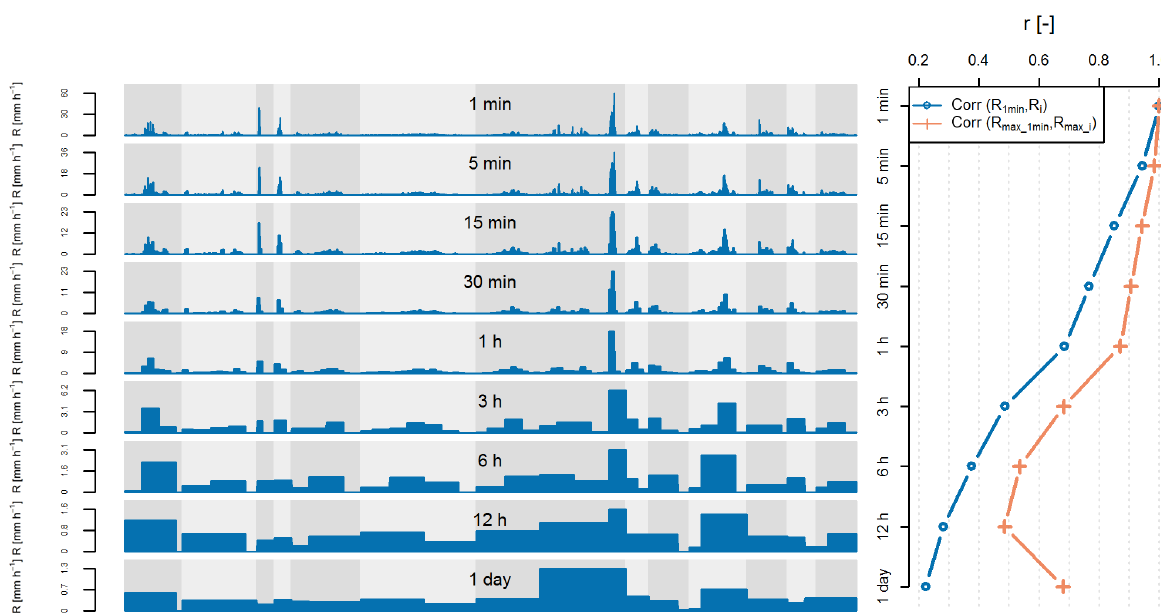
Figure A1. Rainfall peaks smoothed out by longer aggregation intervals, here shown for the case study in Prague-Letˇnany (CZ). Left panels: merged time series of 13 events aggregated to time steps from 1min to 1 day. Vertical stripes indicate individual events. Note how the range of the y axis decreases from the top to the bottom row. Right panels: correlation between time series with 1min resolution and the other time series of different resolutions (blue) and correlation between peak intensities of events derived from rainfall data with 1min resolution and peak intensities derived from aggregated rainfall data